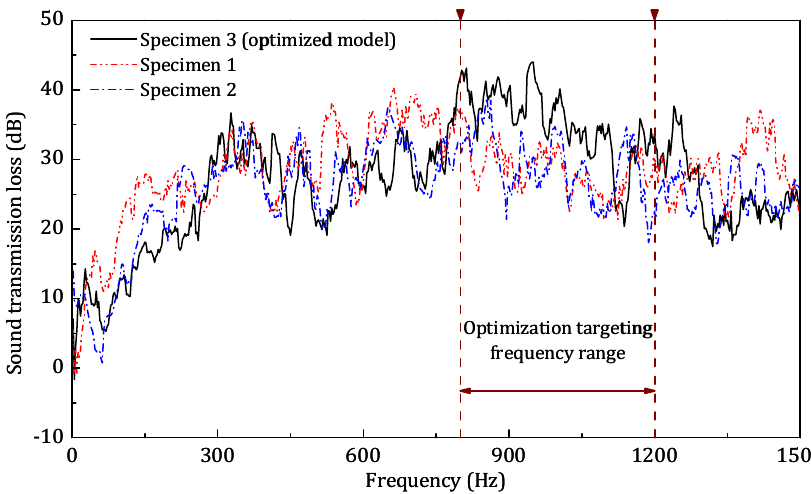
Figure 35. The experimental sound transmission loss of the three specimens.